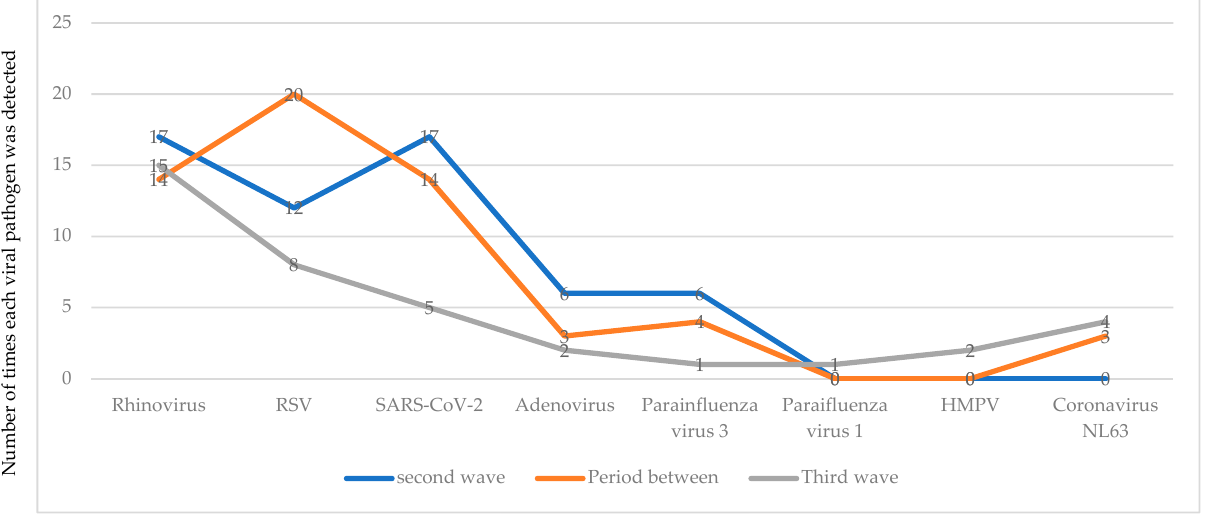
Figure 3. A graphical description on the number of times each viral pathogen was detected across the three study periods (during and between the second and third wave of COVID-19 infection). RSV=respiratory syncytial virus, SARS-CoV-2 = severe acute respiratory syndrome coronavirus 2, HMPV = human metapneumovirus .